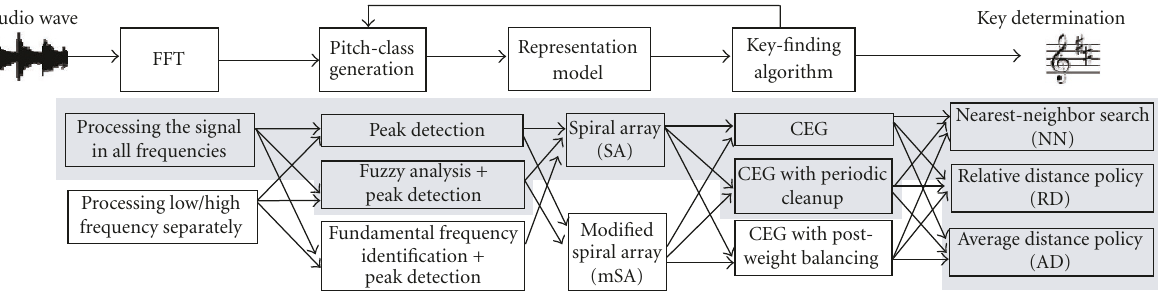
Figure 1: Audio key-finding system (fundamental +